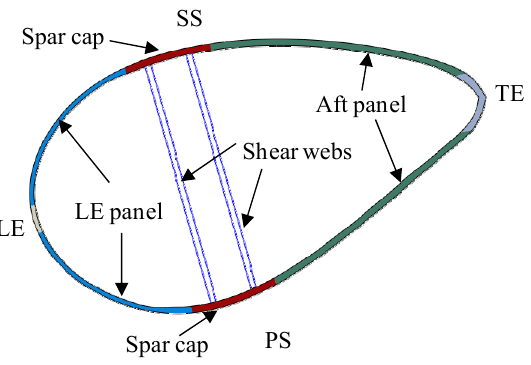
Figure 1. Typical construction of blade